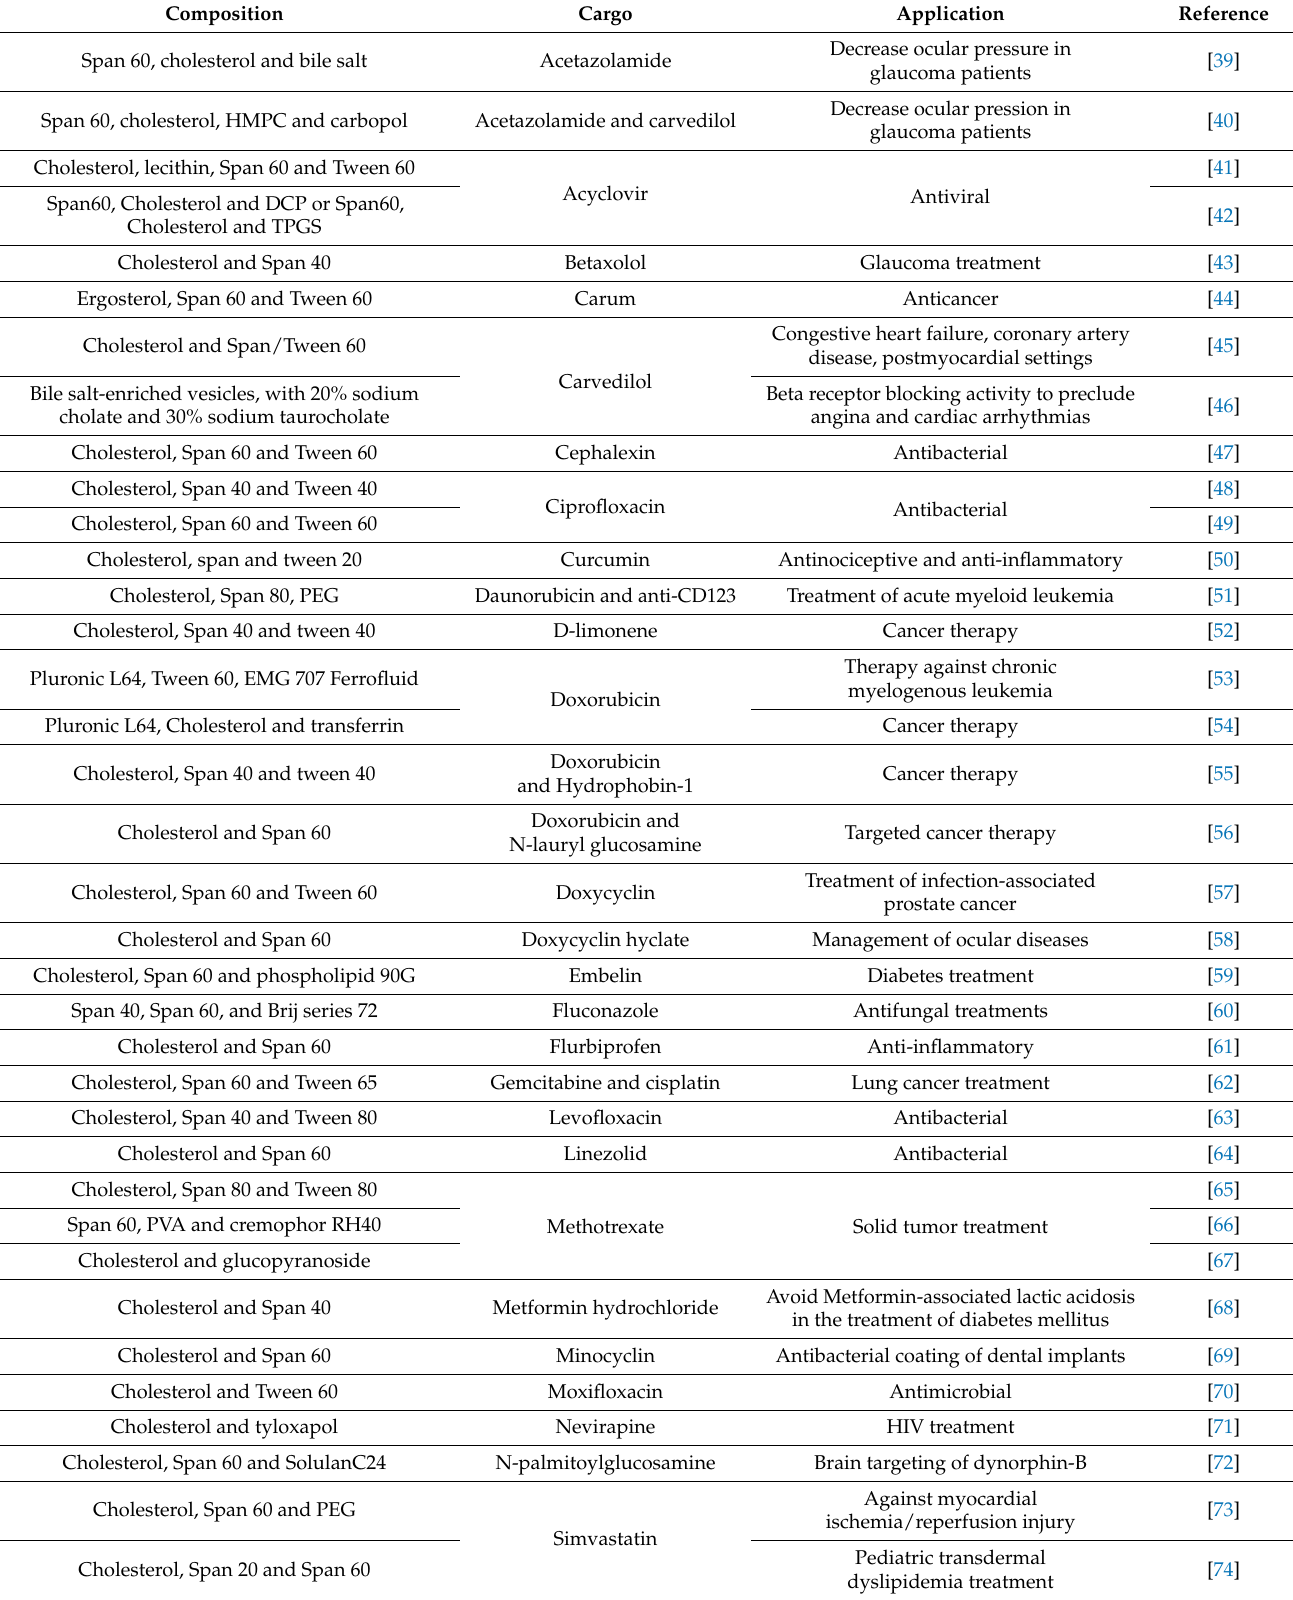
Table 2. Niosomes’ drug delivery